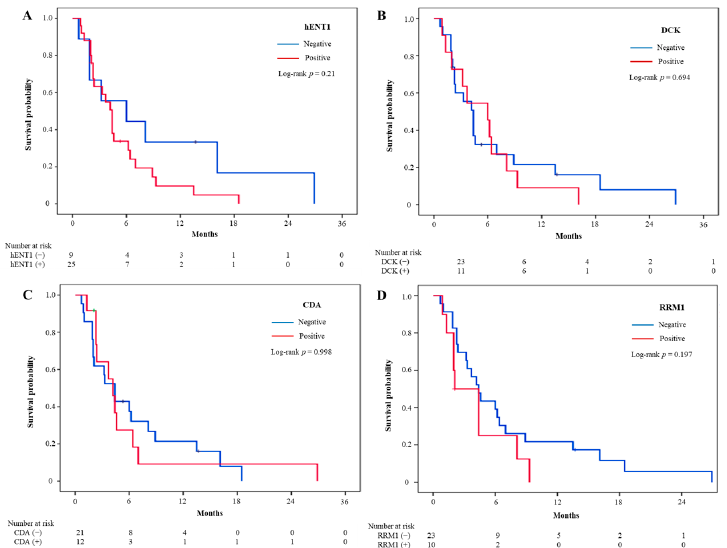
Figure 2. Kaplan–Meier analysis of the relationships of intratumoral expression of biomarkers with progression-free survival in patients with biliary tract cancers. ( A ) hENT1, ( B ) DCK, ( C ) CDA, ( D ) RRM1. hENT1, human equilibrative nucleoside transporter 1; DCK, deoxycytidine kinase; CDA, Cytidine deaminase; RRM1, ribonucleotide reductase subunit 1.